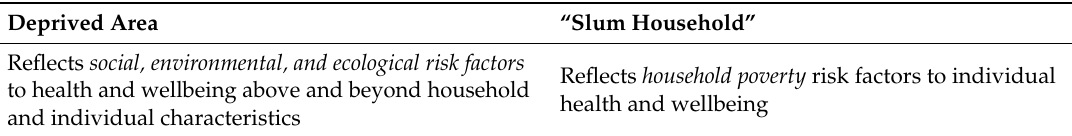
Table 1. Definition of a deprived area (slum, informal settlement, area of inadequate housing) versus “slum